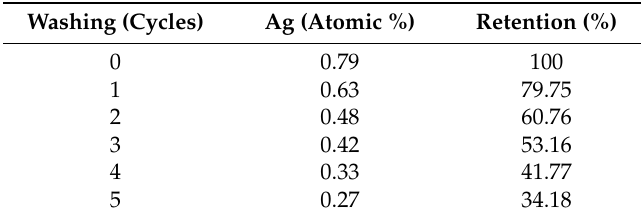
Table 2. Washing fastness of GTAC/AgNPs-treated p -aramid.